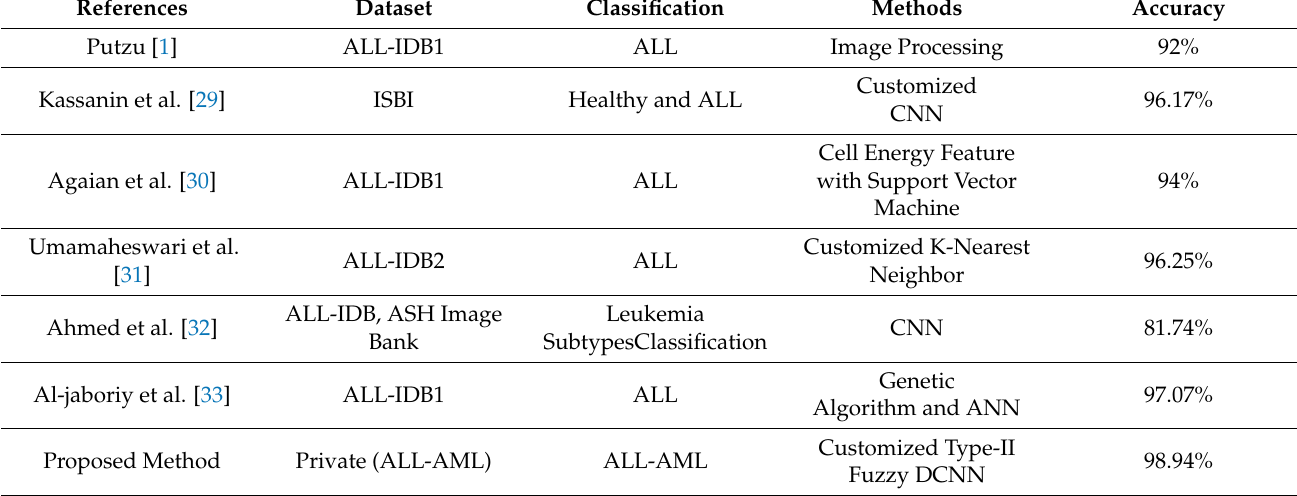
Table 4. The accuracy of various methods for leukemia